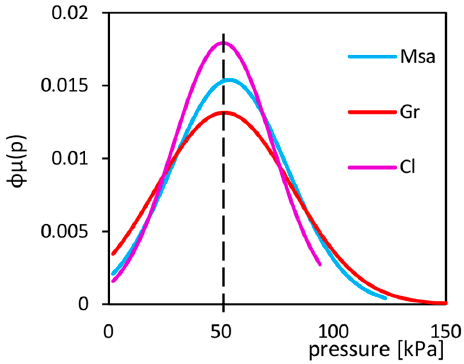
Figure 9. The stress probability distribution functions for soils with different grain sizes, Msa—Medium sand, Gr—Gravel, Cl—Clay.